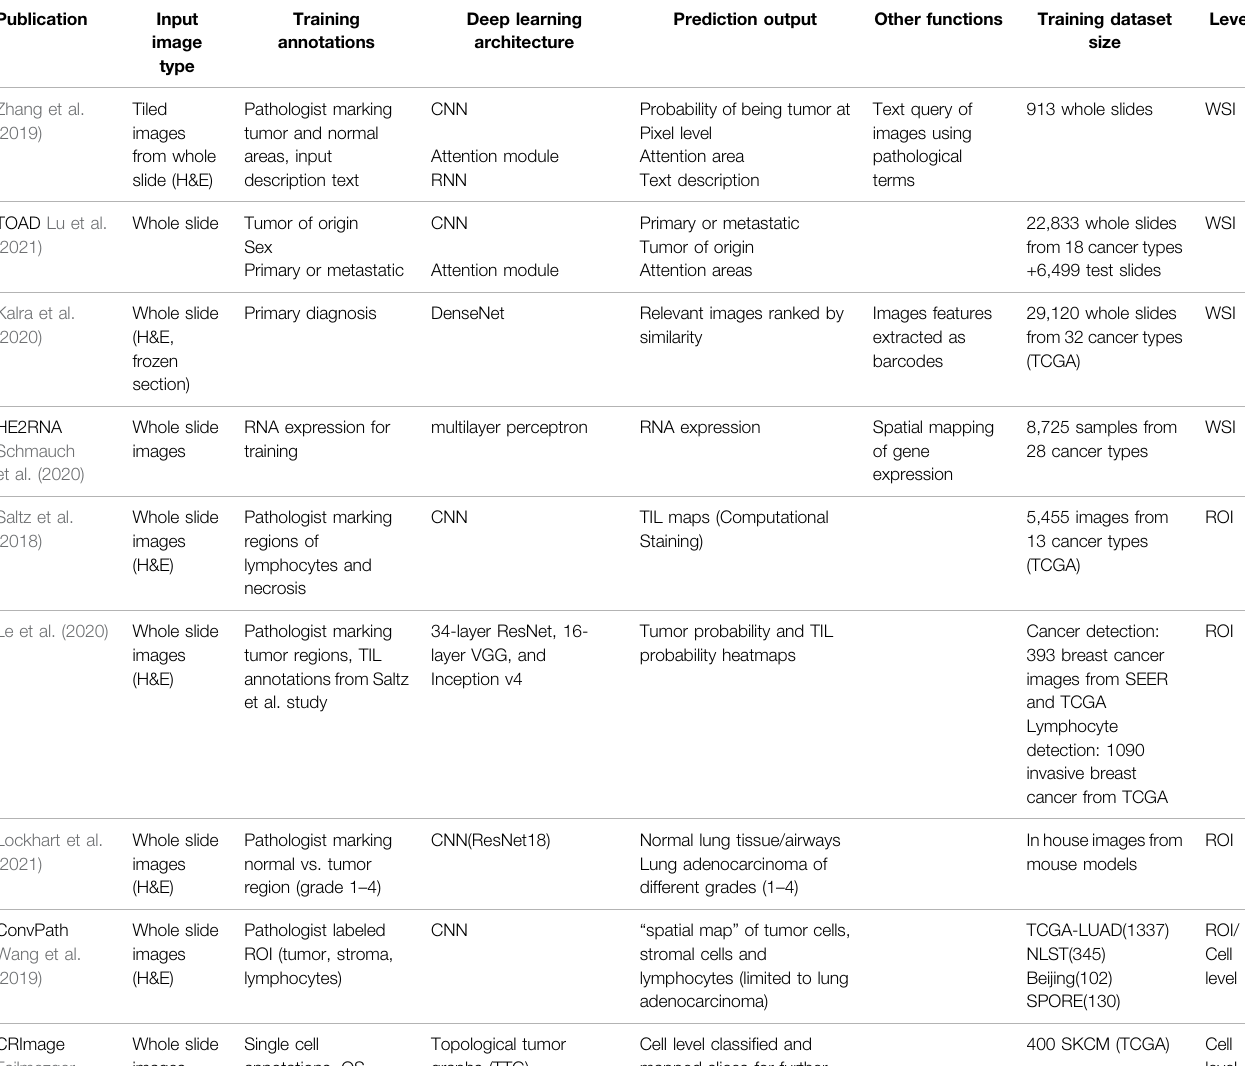
TABLE 1 | Selected deep learning-based histopathology image analysis